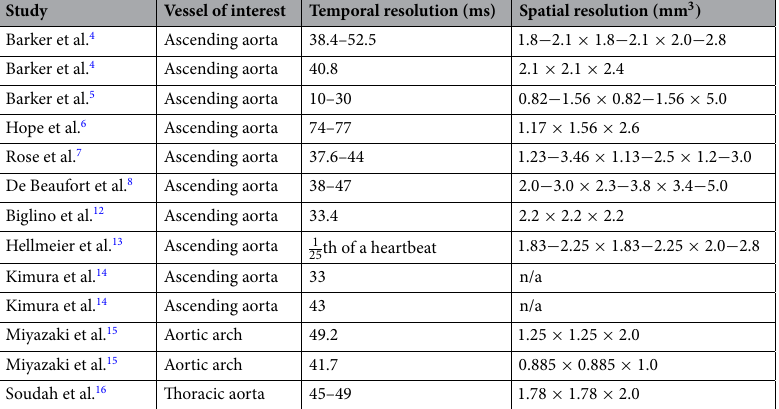
Table 1. Spatial and temporal resolutions of 4D-Flow MRI scans used in recent studies (2010–2019) that have utilised 4D-Flow MRI to acquire haemodynamic